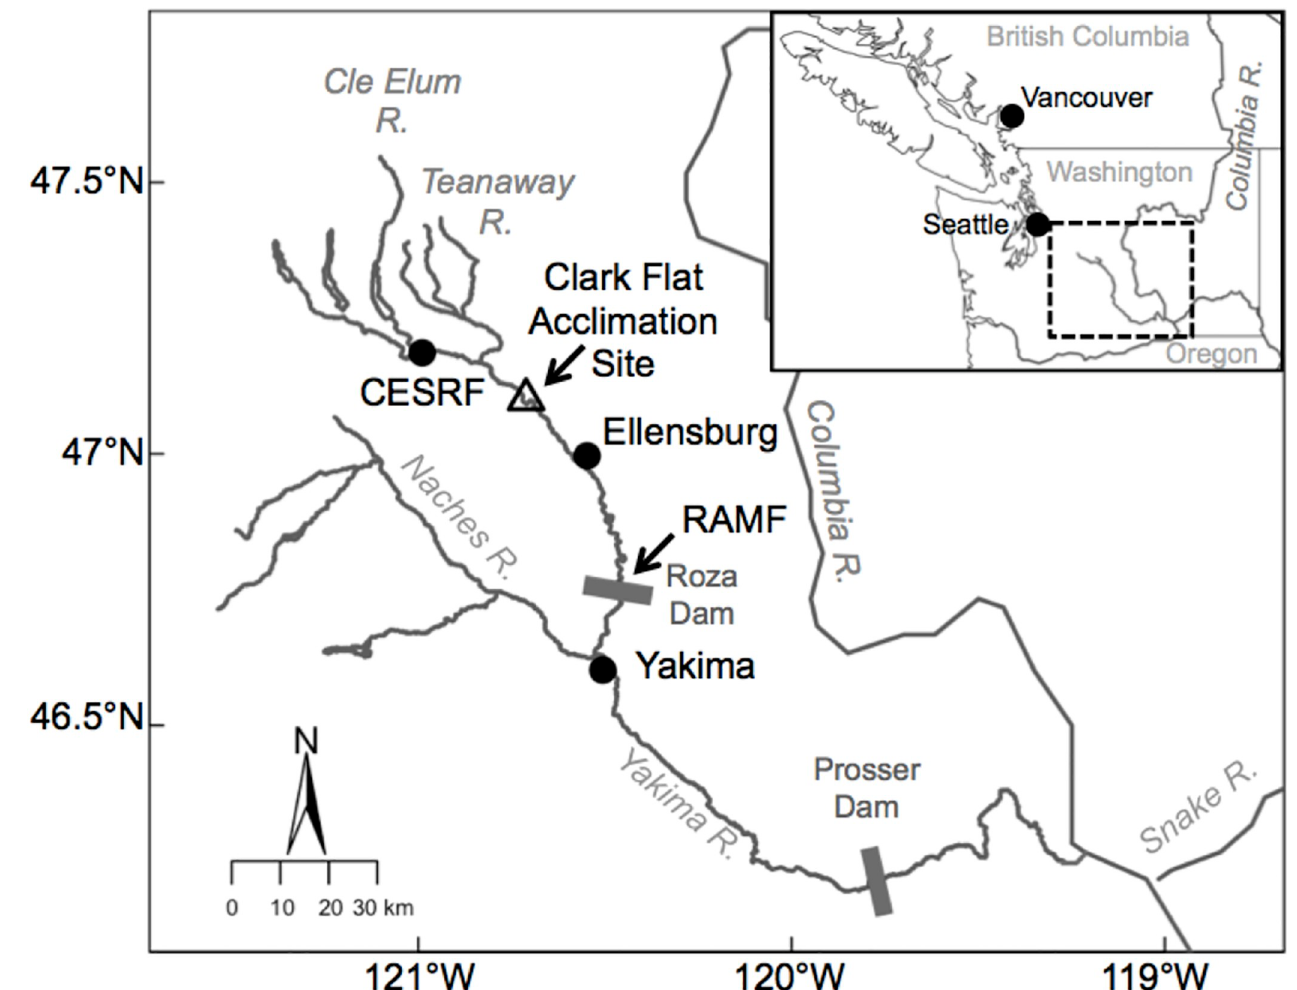
Fig 1. Location of study sites in the Yakima River basin (dashed box in inset), WA, USA.